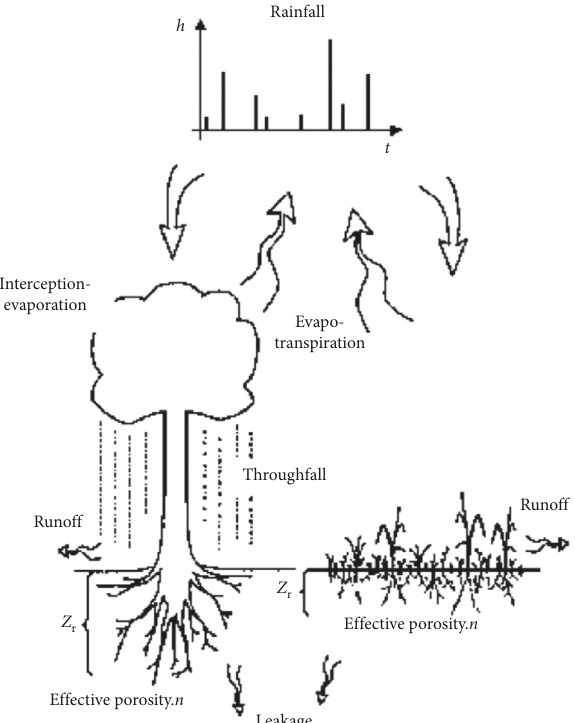
Figure 4: Schematic representation of the various mechanisms of two different vegetation types that play a role in the soil water balance